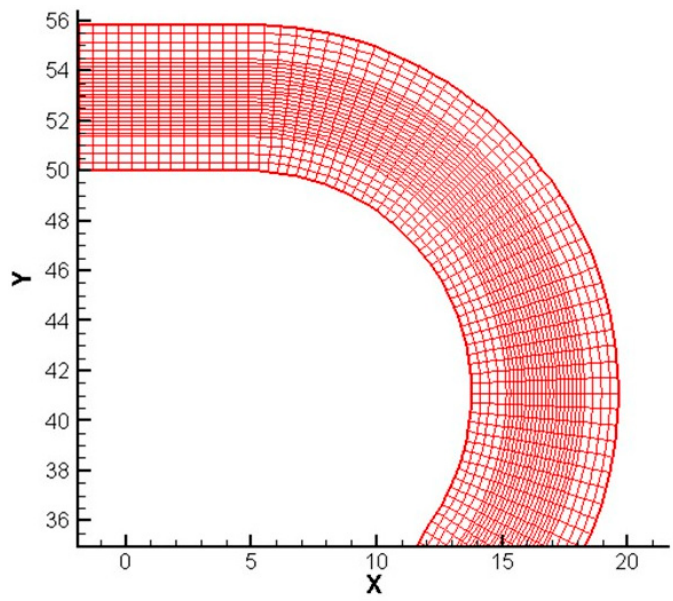
Figure A3. A close-up view of the mesh for the SRH-2D model for the upstream channel curve.